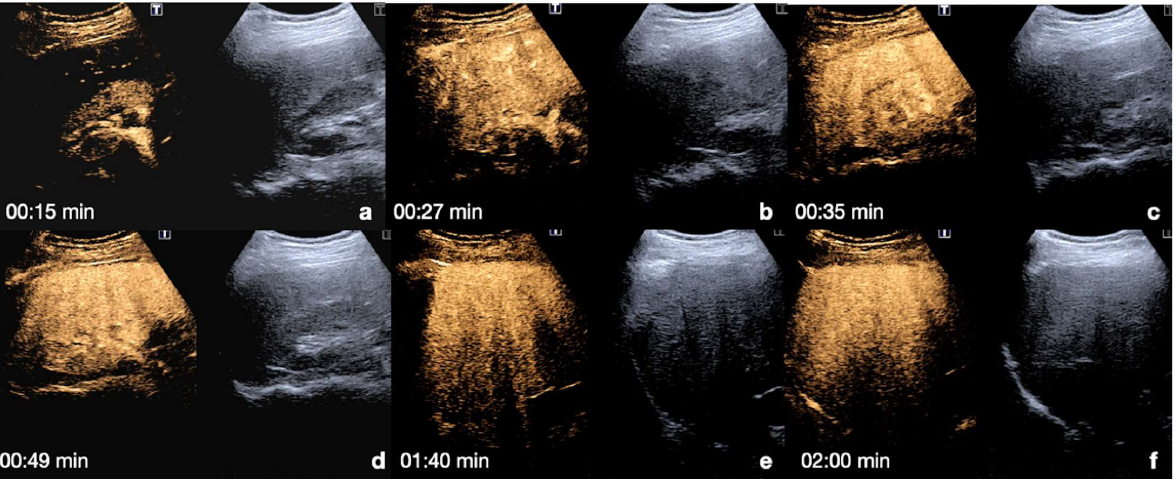
Figure 5. CEUS findings in a normal liver ( a – f ). Note the progressive physiological enhancement of the liver in the different phases. Figure 5 is reprinted with permission from Iacobellis F., Acampora C., Ponticiello C., Stavolo C., Scuderi M.G., Cinque T., Pinto A., Gagliardi N., Romano L. Technique